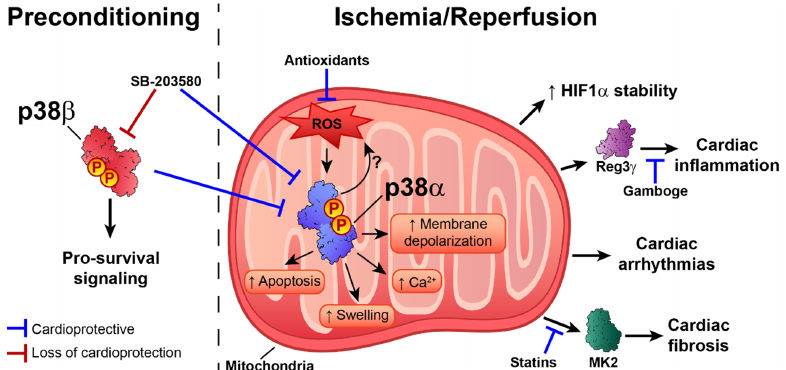
Figure 2. Dual role of p38 activation during preconditioning and ischemia–reperfusion injury. Activation of p38 β during preconditioning triggers pro-survival signaling pathways,